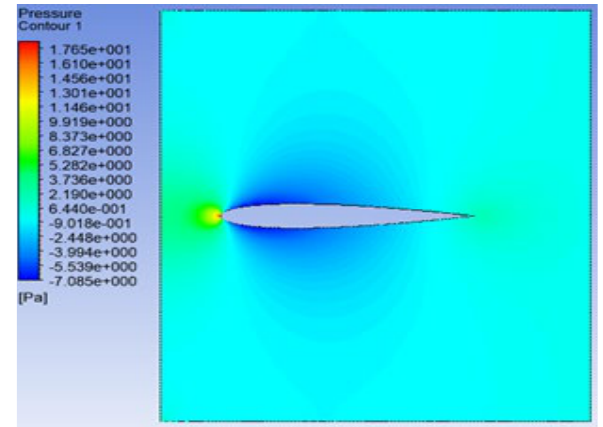
Figure 6. Pressure variation of